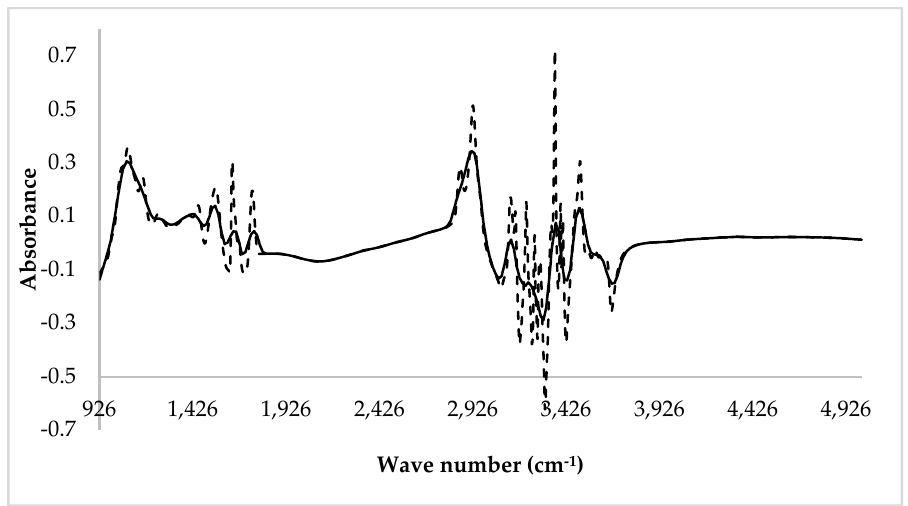
Figure 2. Raw (dotted line) and LOWESS corrected (solid line) MIR milk spectrum of an ewe.